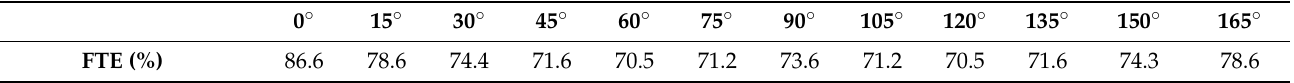
Table 2. FTE values for different infield track orientations.